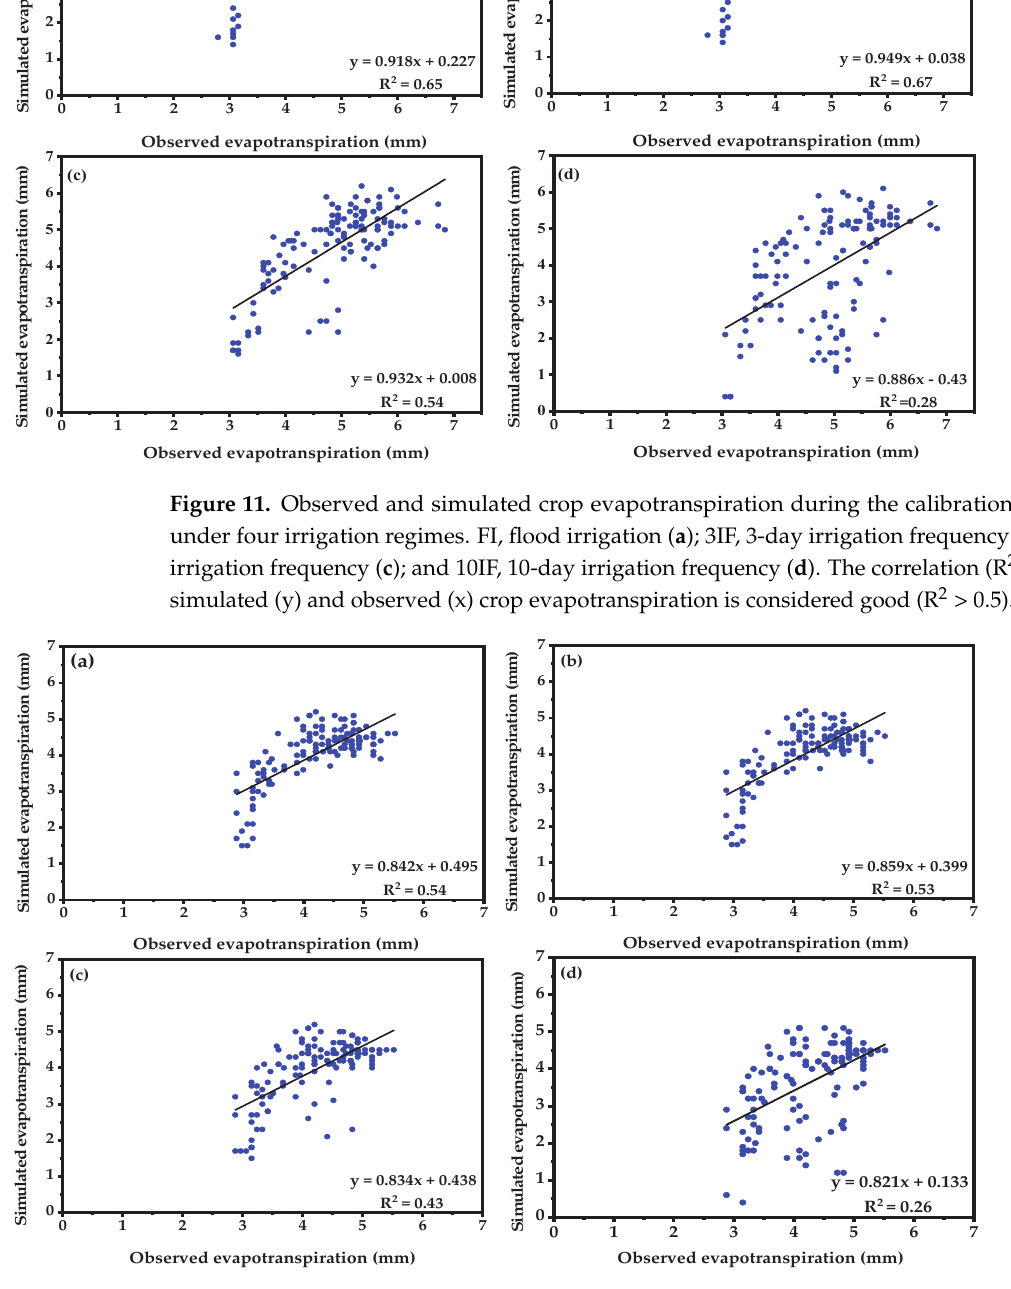
Figure 12. Observed and simulated crop evapotranspiration during the validation period (2020) under four irrigation regimes. FI, flood irrigation ( a ); 3IF, 3-day irrigation frequency ( b ); 6IF, 6-day irrigation frequency ( c ); and 10IF, 10-day irrigation frequency ( d ). The correlation (R 2 ) between the simulated (y) and observed (x) crop evapotranspiration is considered good (R 2 > 0.5). Table 6. K-fold cross-validation results (5 folds).